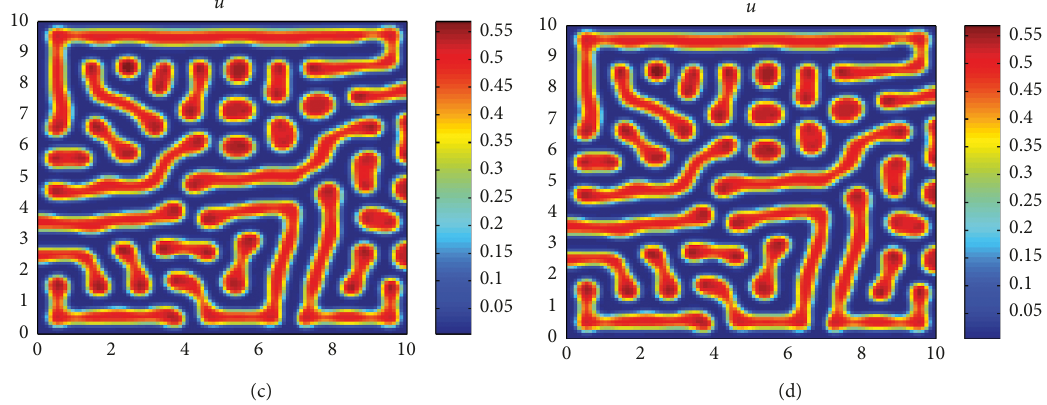
Figure 5: Mixture patterns obtained with model (1) for A � 0 . 02 and τ � 0 . 02. Time: (a) t � 100, (b) t � 500, (c) t � 2000, and (d) t �